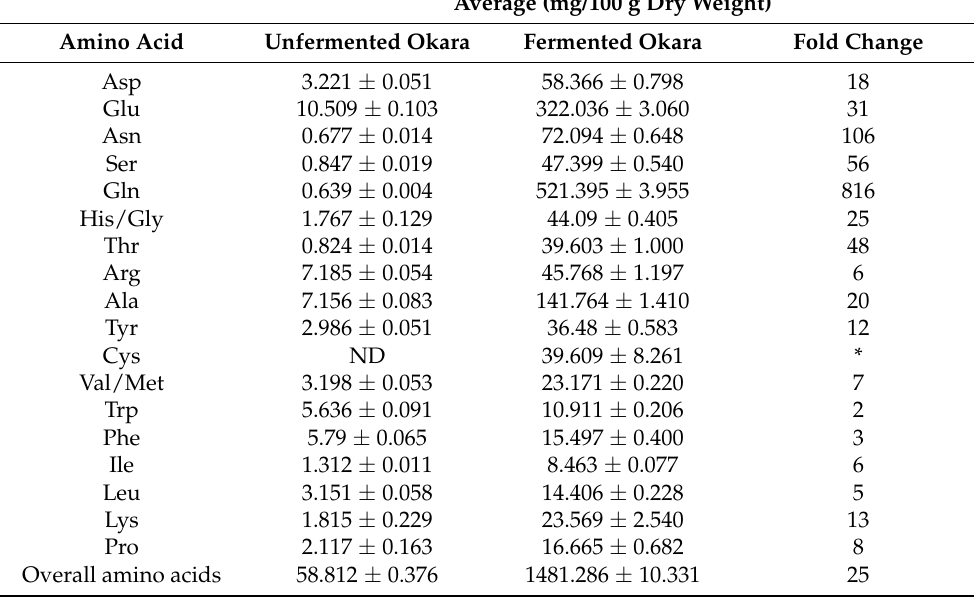
Table 2. Amino acid concentration of okara before and after fermentation. Data represent mean ± standard deviation of three replicates ( p < 0.05). ND—not detected, i.e., the amount of amino acids lower than